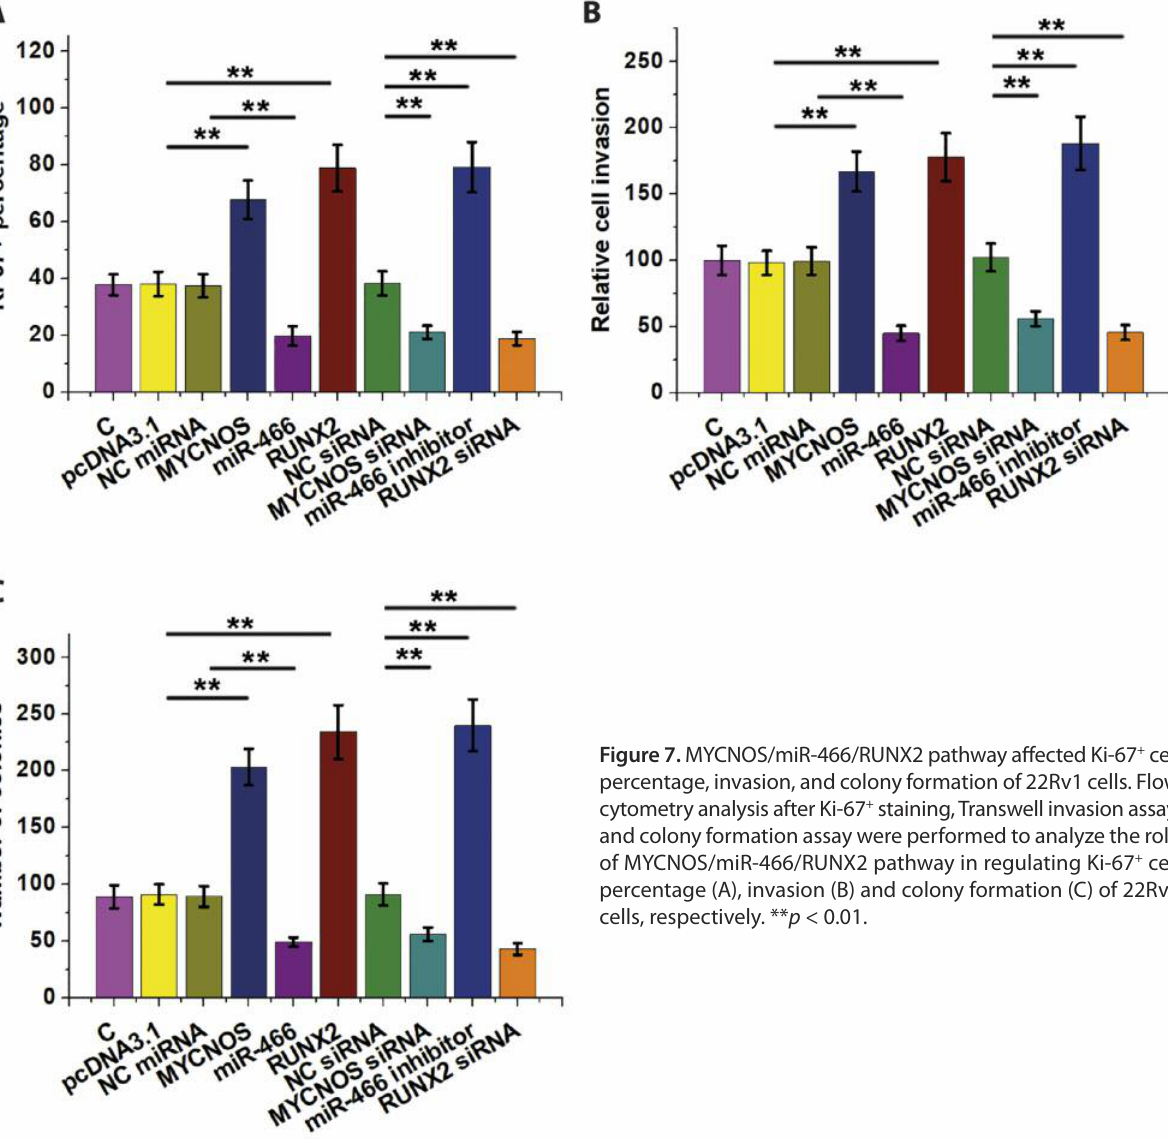
Figure 7. MYCNOS/miR-466/RUNX2 pathway a ff ected Ki-67 + cell percentage, invasion, and colony formation of 22Rv1 cells. Flow cytometry analysis after Ki-67 + staining, Transwell invasion assay, and colony formation assay were performed to analyze the role of MYCNOS/miR-466/RUNX2 pathway in regulating Ki-67 + cell percentage (A), invasion (B) and colony formation (C) of 22Rv1 cells, respectively. ** p <